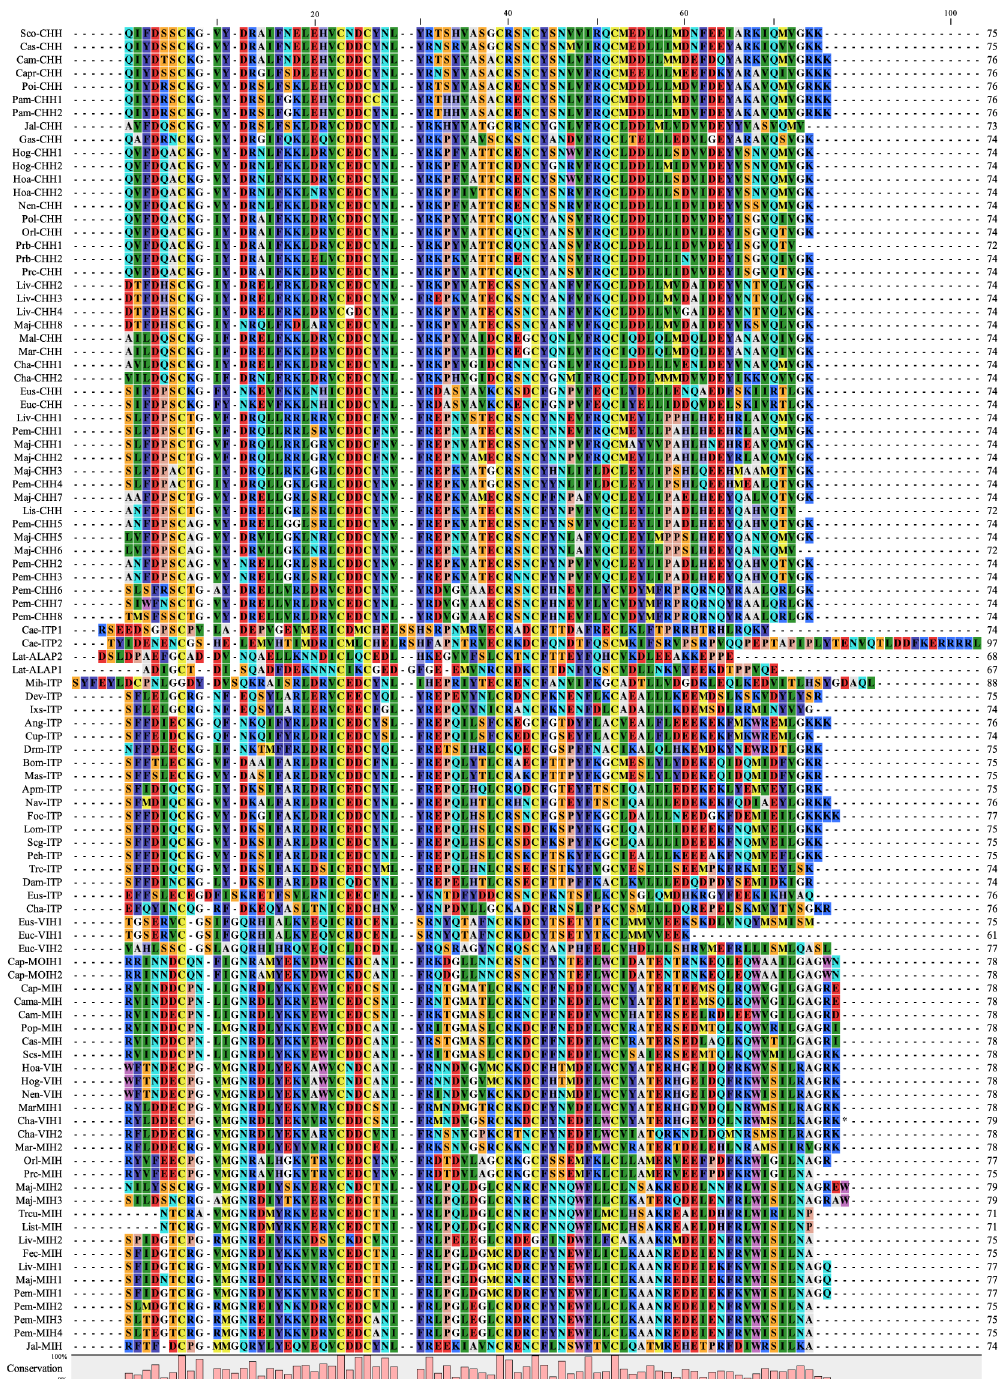
Fig 6. Multiple sequence alignment of representative peptides of the CHH family. Residues are numbered according to Sco-CHH. Sequences aligned are from the following sources: Anopheles gambiae : Ang-ITP (sequence deduced from genomic sequences, 9); Apis mellifera : Apm-ITP (XP_001120062); Bombyx mori : Bom-ITP (AAY29659); Caenorhabditis elegans : Cae-ITP1 (Q23247), Cae-ITP2 (NP_508782); Cancer magister : Cama-MIH (O61389); Callinectes sapidus : Cas-CHH (AAS45136), Cas-MIH (P55321); Carcinus maenas : Cam-CHH (P14944), Cam-MIH (Q27225); C . productus : Capr-CHH (ABQ41269), Cap-MOIH1 (CAC05347), Cap-MOIH2 (CAC05348), Cap-MIH (CAC05346); Chorismus antarcticus : Cha-CHH1, Cha-CHH2, Cha-ITP, Cha- VIH1, Cha-VIH2 (unpublished data); Culex pipens : Cup-ITP (XP_001845654); Daphnia magna : Dam-ITP (ABO43964); Dermacentor variabilis : Dev-ITP (ACC99599); Drosphila melanogaster : Drm-ITP (ABZ88142); Euphausia crystallorophias : Euc-CHH, Euc-VIH1, Euc-VIH2 ( E . crystallorophias ERP002510); E . superba : Eus-CHH, Eus-ITP; Eus-VIH1 ( E . superba transcriptome SRA023520); Fenneropenaeus chinensis : Fec-MIH (AAL55258); Folsomia candida :